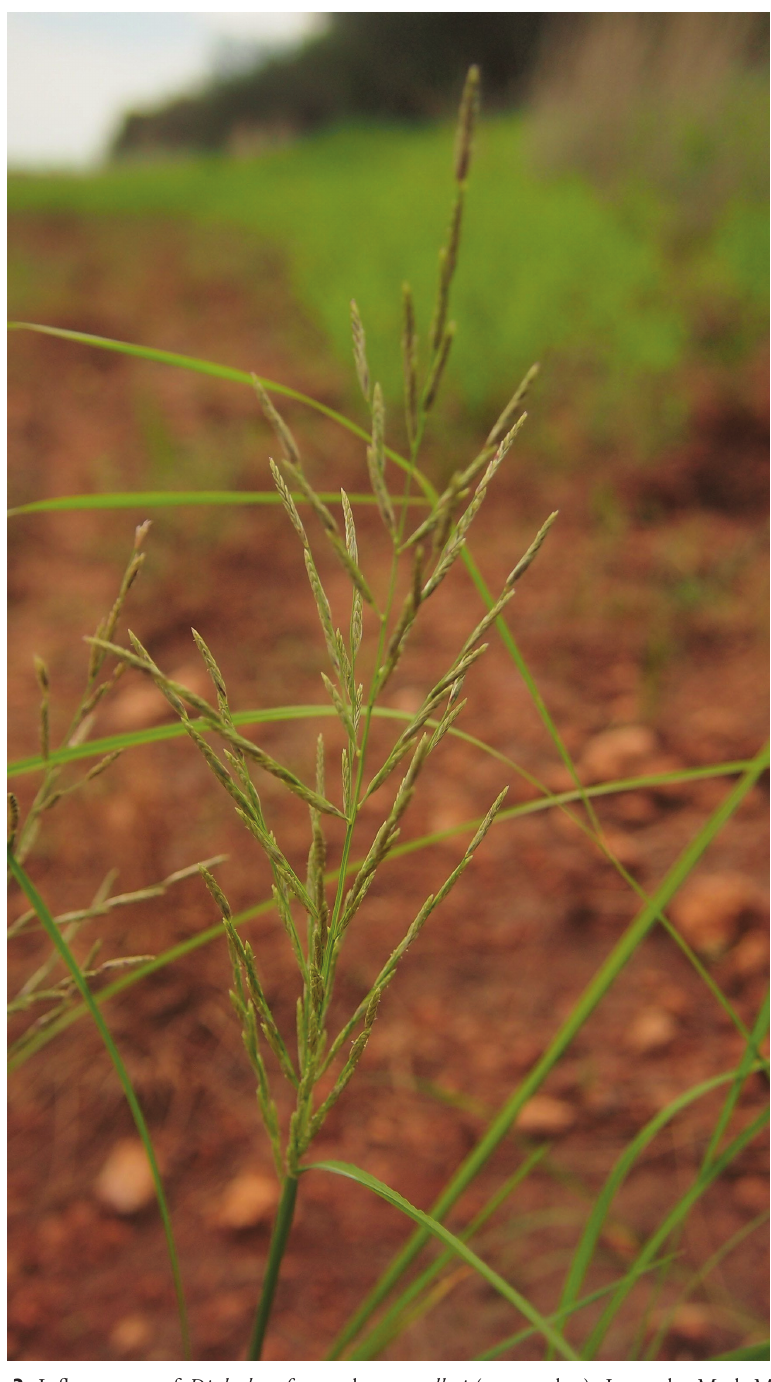
Figure 3. Inflorescence of Diplachne fusca subsp. muelleri (no voucher). Image by Mark Marathon